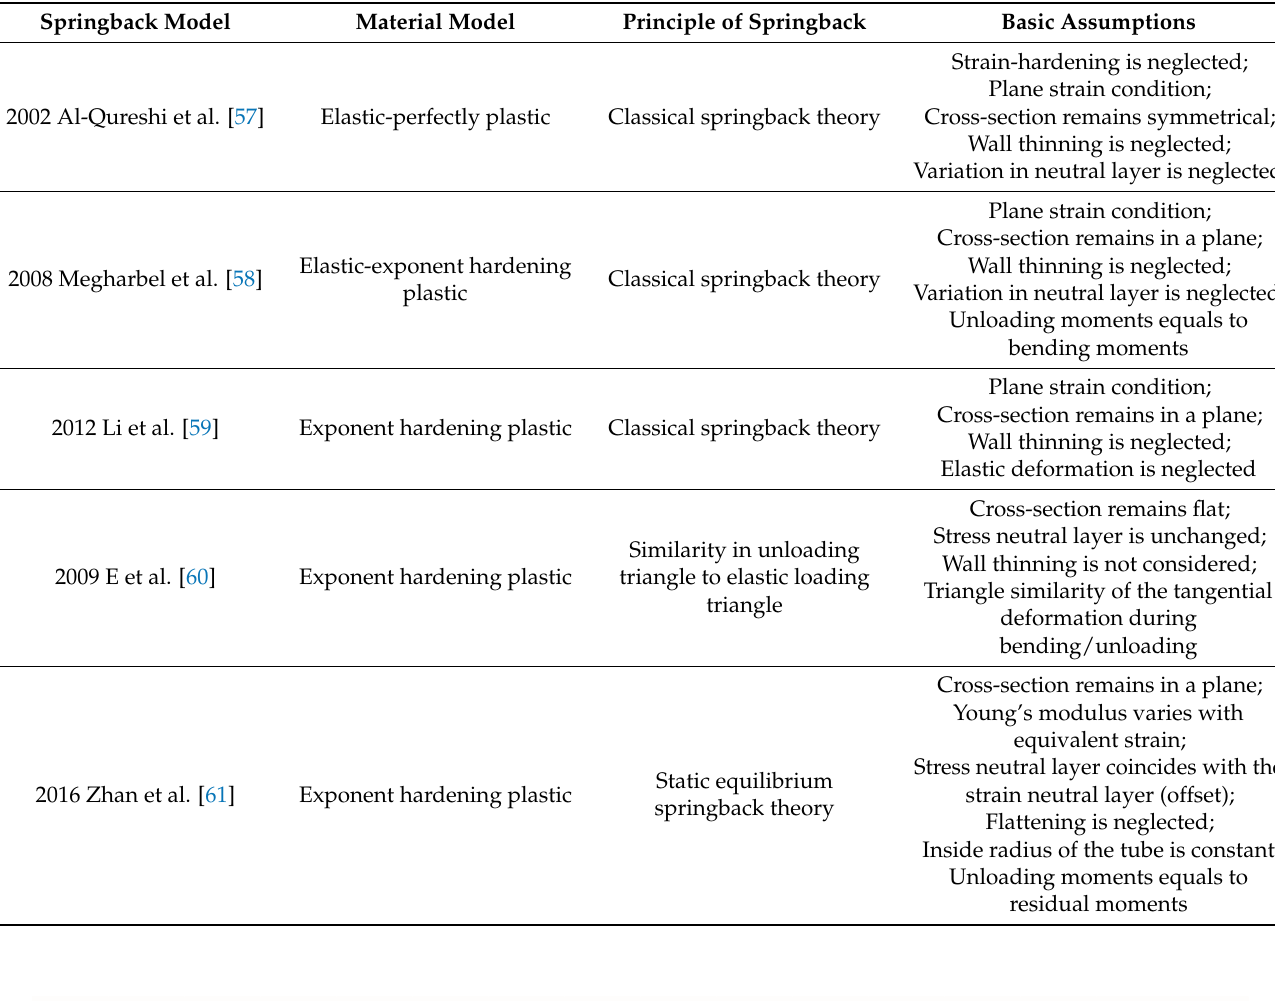
Table 1. Comparison of the springback prediction models.